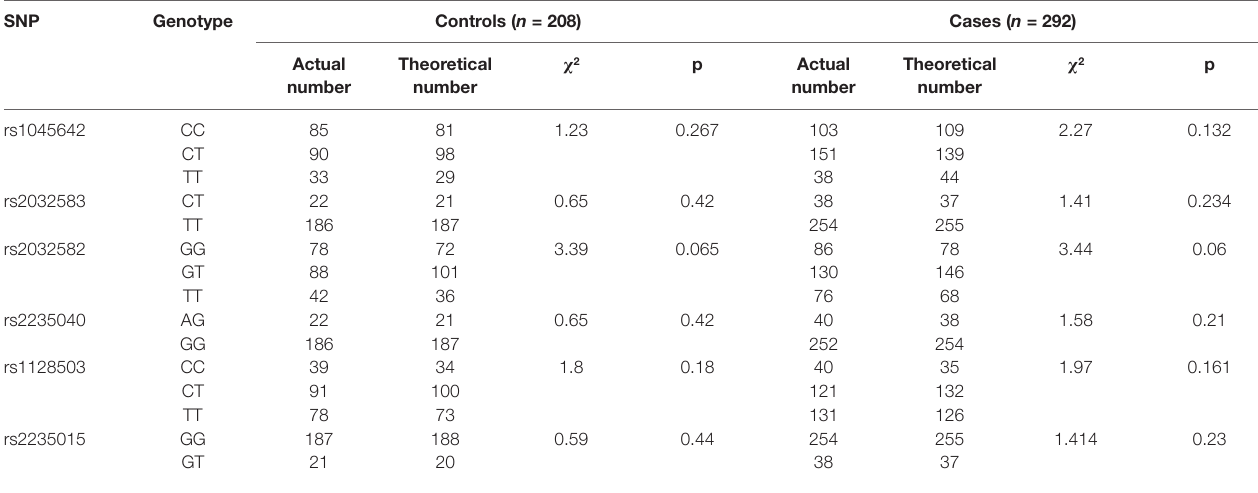
TABLE 1 | Equilibrium test of six single-nucleotide polymorphisms (SNPs) between the control group and the case group. SNP Genotype Controls ( n =